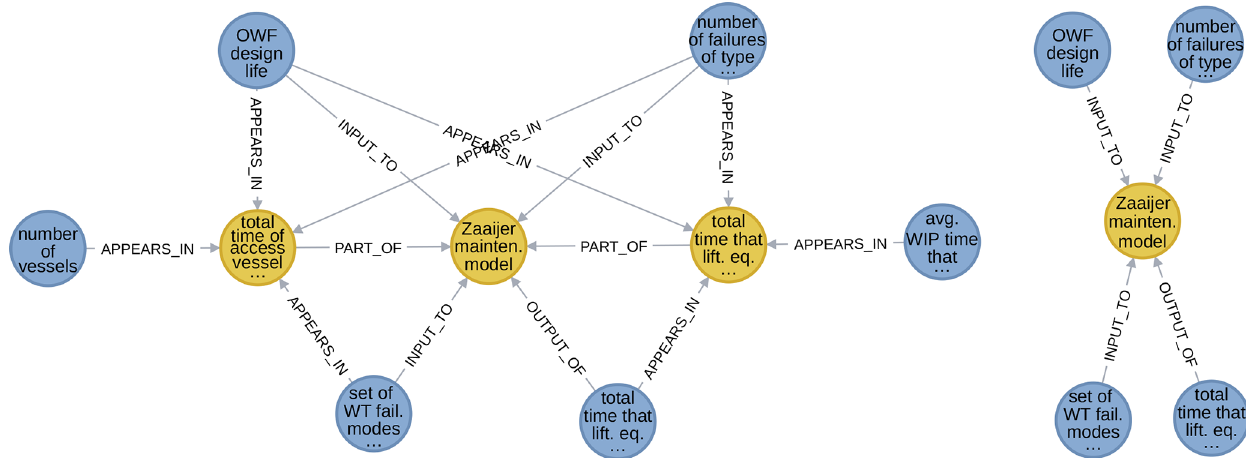
Figure 17. WESgraph excerpt showing an overview model and part of its low-level description (a) . The same, except with internal nodes removed (b)